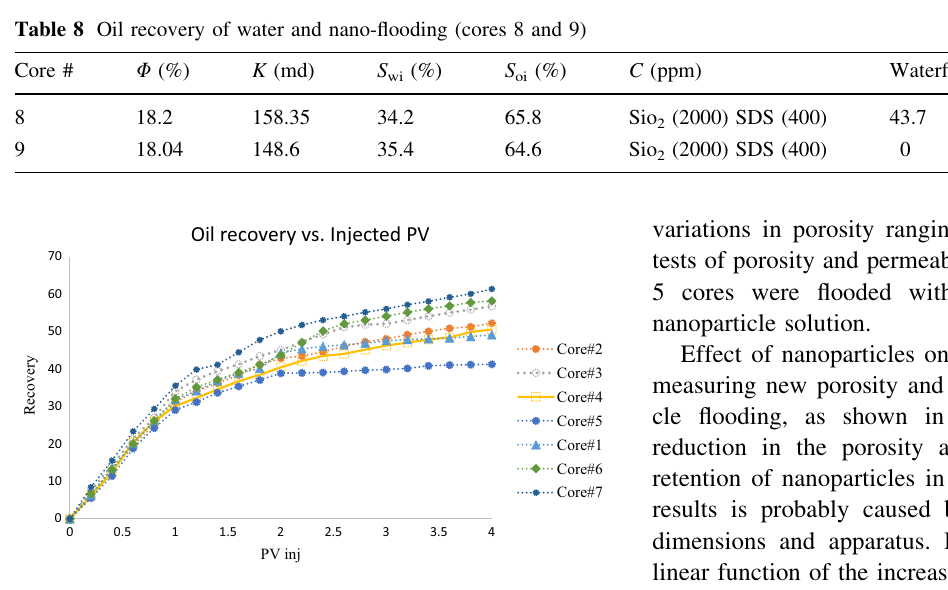
Fig. 13 Profile of recovery versus pore volume injected